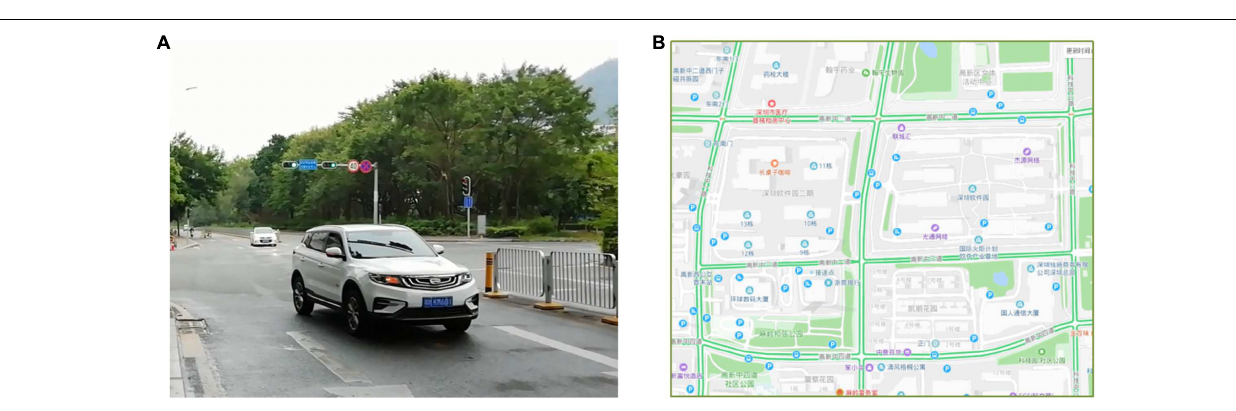
Frontiers in Neurorobotics |